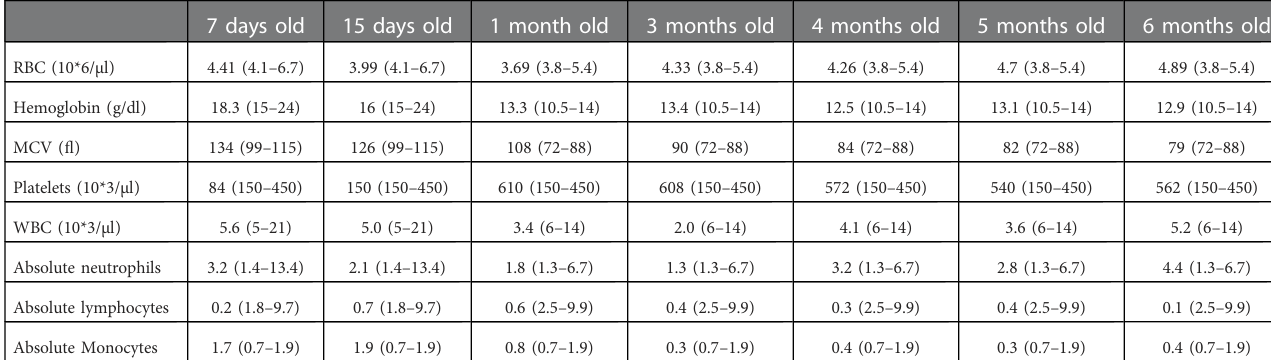
TABLE 1 Patient ’ s complete blood counts with age speci fi c normal values are given on parenthesis. Trend over